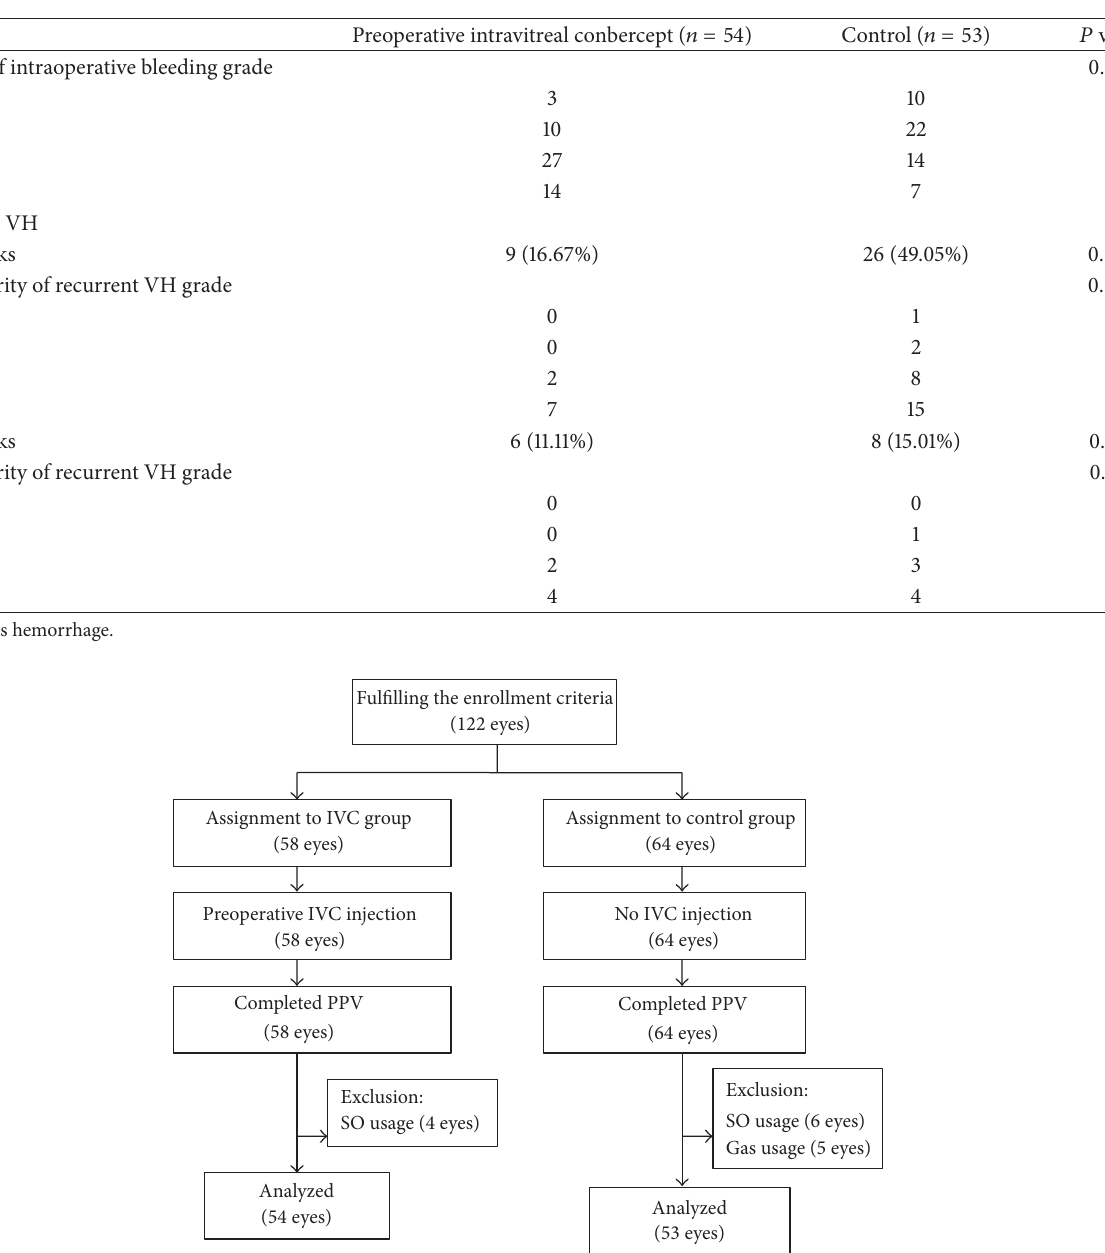
Table 2: Surgical procedures and outcomes of participants with or without conbercept pretreatment.